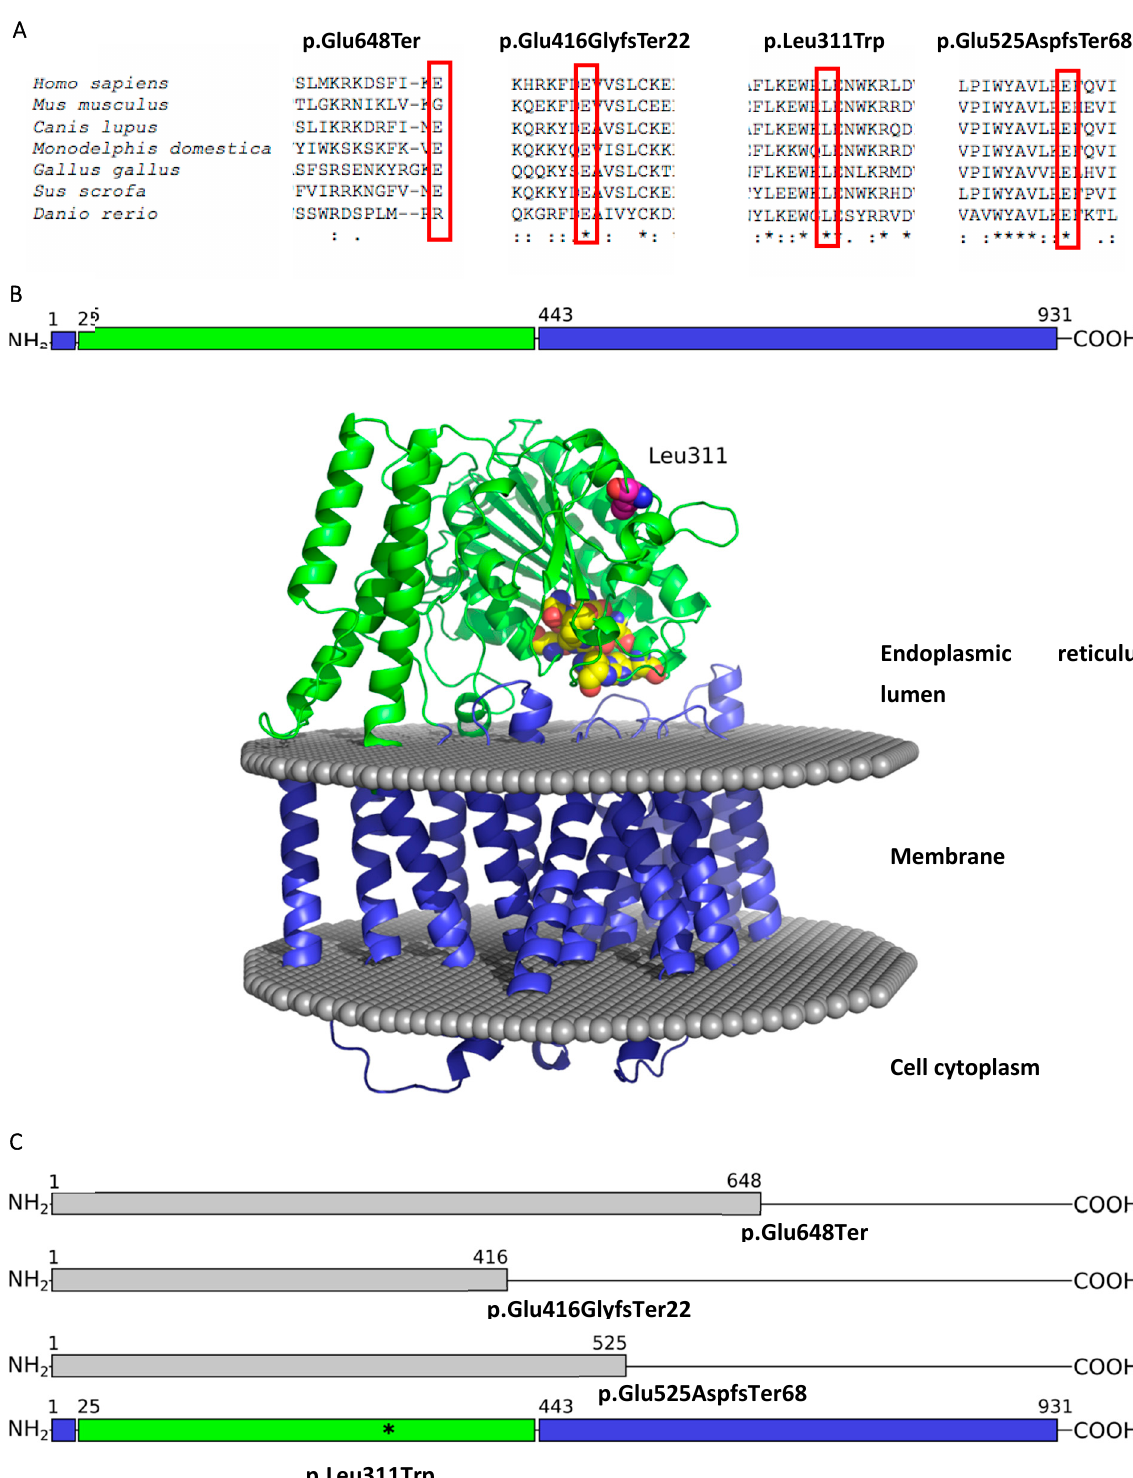
Figure 2. ( A ) Multiple sequence alignment produced by ClustalO of the PIGN protein across seven evolutionarily distant species. Below the amino acid sequences is a key denoting conserved sequence (*), conservative variants (:), semi-conservative variants (.), and non-conservative variants (); ( B ) The domain organization and structure model of human PIGN protein. The membrane region is coloured in blue, the lumenal domain is green, mutated residue Leu311 is shown in magenta coloured spheres, conserved residues that are likely to belong to enzyme active site are shown in yellow spheres; ( C ) Pathogenic or likely pathogenic variants visualized on the protein sequence.